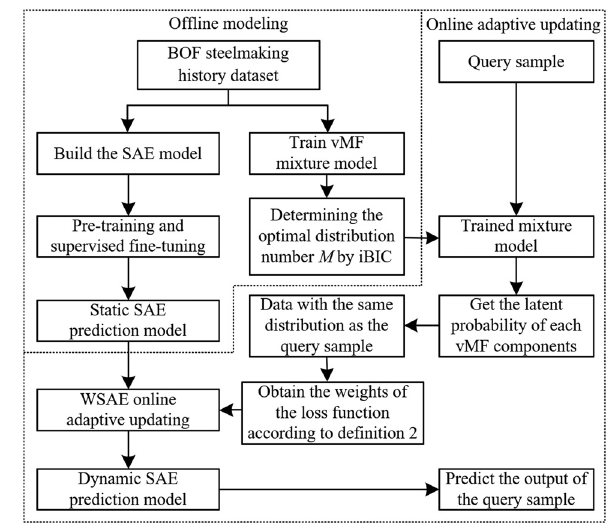
Figure 5: The fl owchart of the proposed vMF - WSAE - based soft sensor